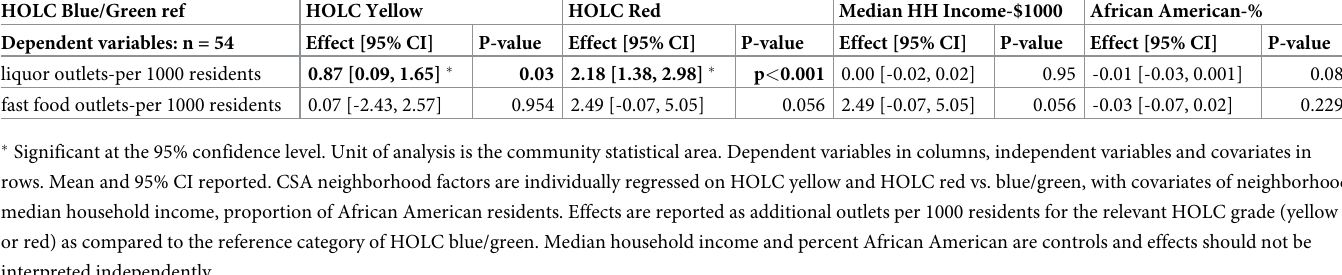
Table 5. Multivariable ordinary least squares analysis of Baltimore HOLC and 2013 neighborhood characteristics.